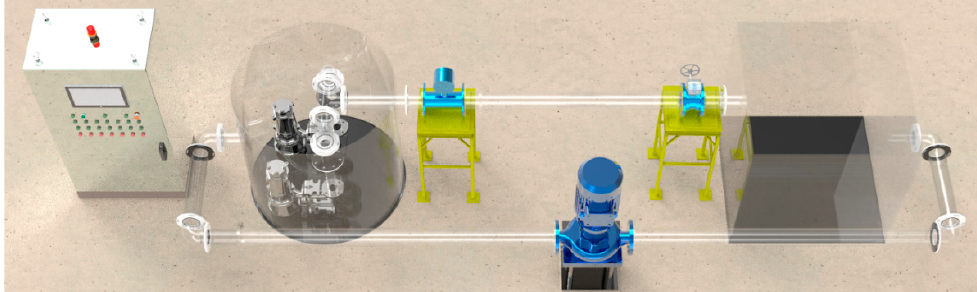
Figure 3. Sketch of centrifugal prefabricated pumping station test bench: 1. PLC frequency conver- sion control cabinet; 2. Prefabricated barrel; 3. Submersible centrifugal pump; 4. Coupler; 5. Electro- magnetic flow meter; 6. Pipeline pump; 7. Butterfly valve; 8. Water return tank.